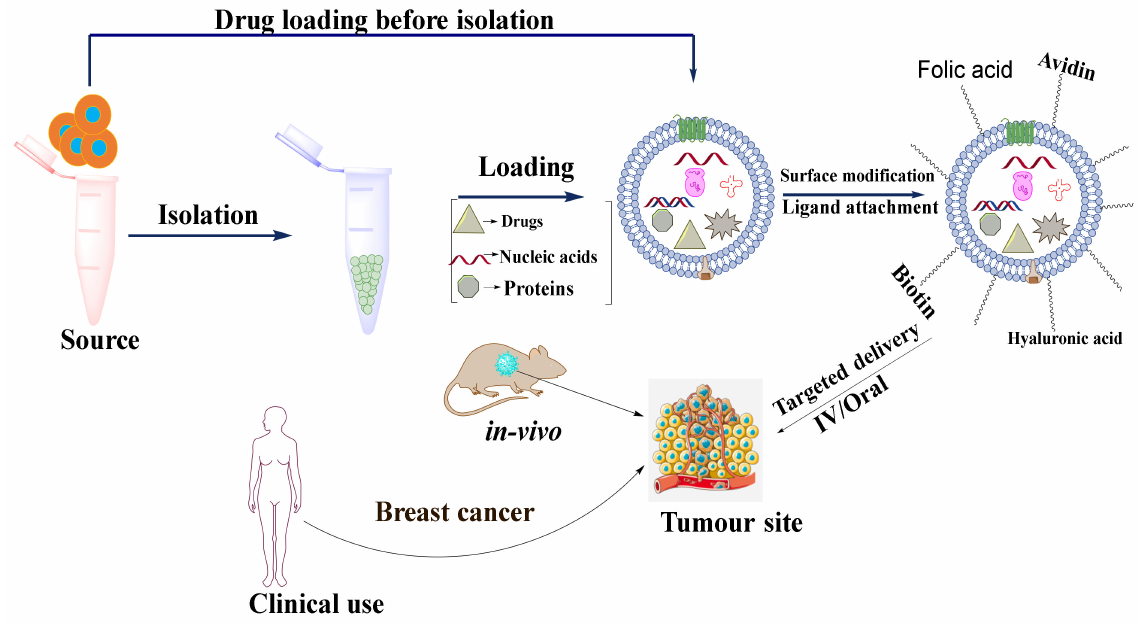
Figure 6. Schematic diagram showing the application of exosomes as a nanocarrier for targeted drug delivery in